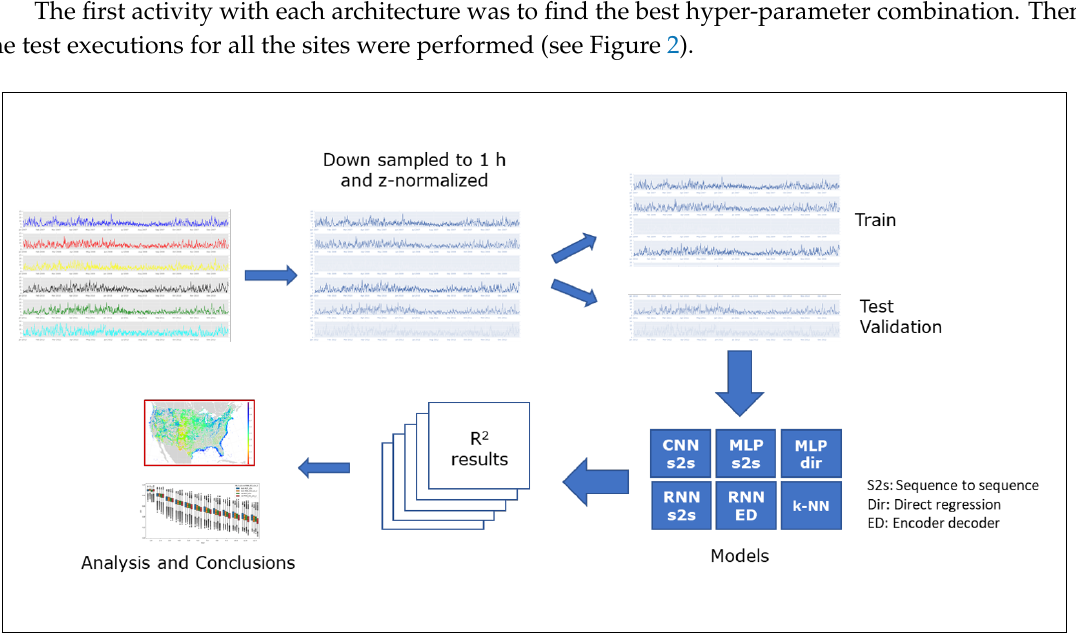
Figure 2. Prediction methodology used in this